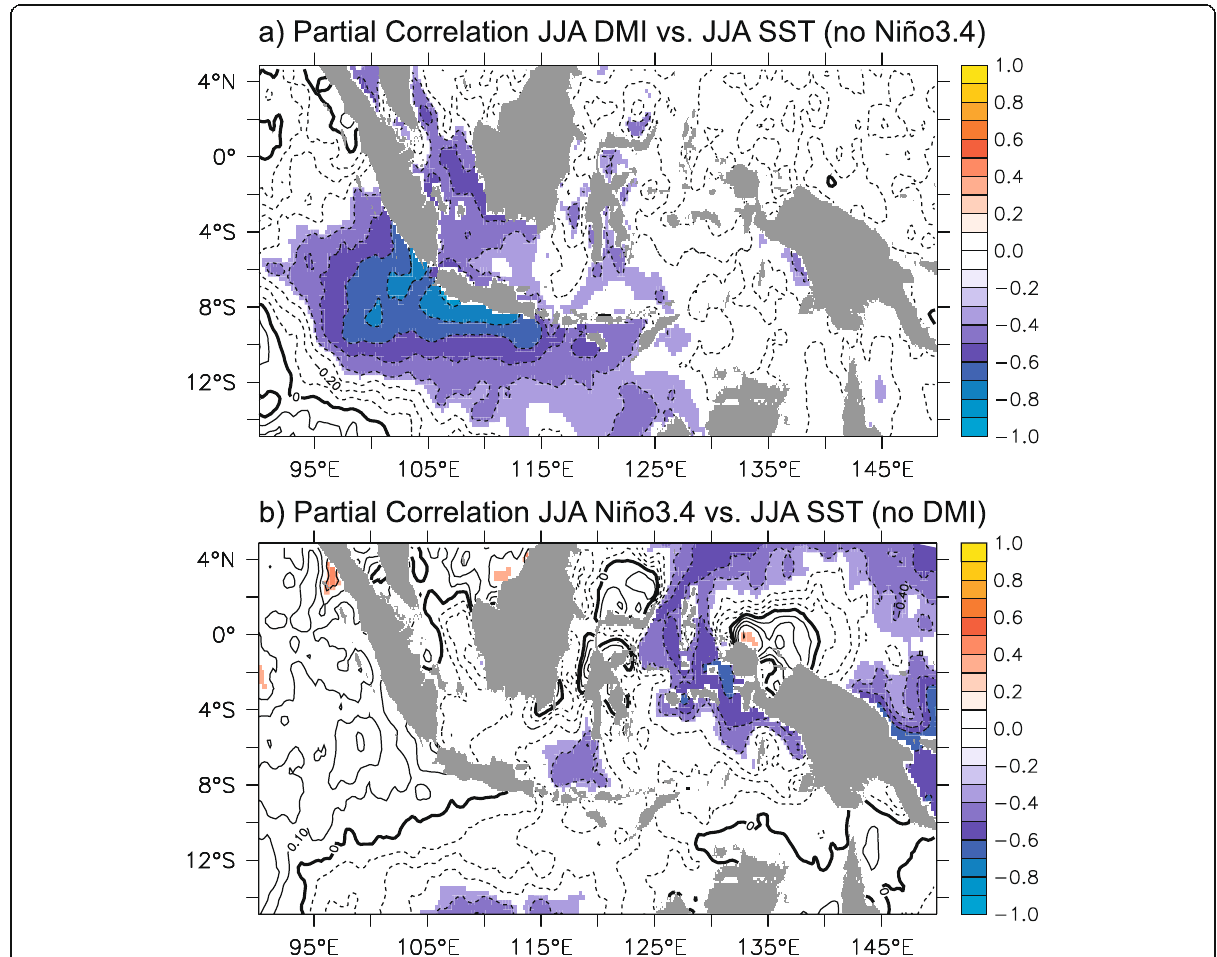
Fig. 6 Partial correlation coefficient between JJA SST and a Dipole Mode Index, and b Niño3.4 index. Values above 95% confidence level are